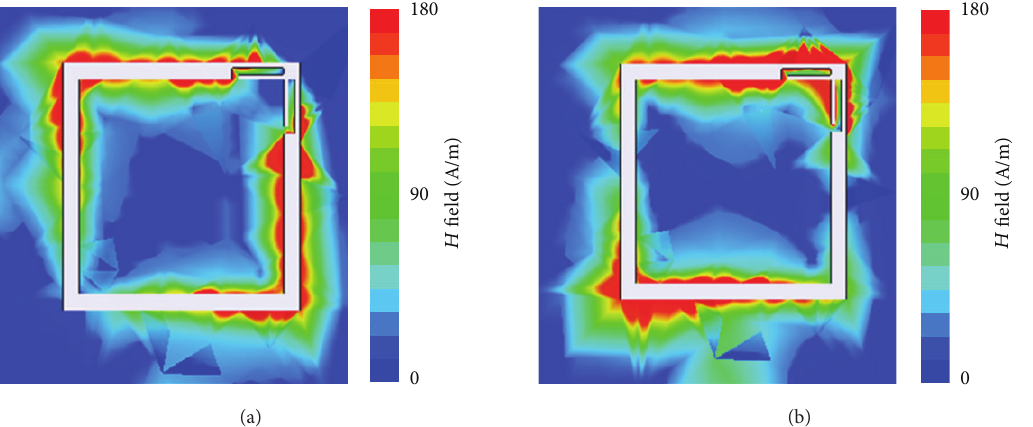
Figure 4: Simulated current distributions for two degenerate modes with an elliptic characteristic (spurlines on corner B): (a) 𝑓 1 = 7.5 GHz; (b) 𝑓 2 = 7.59